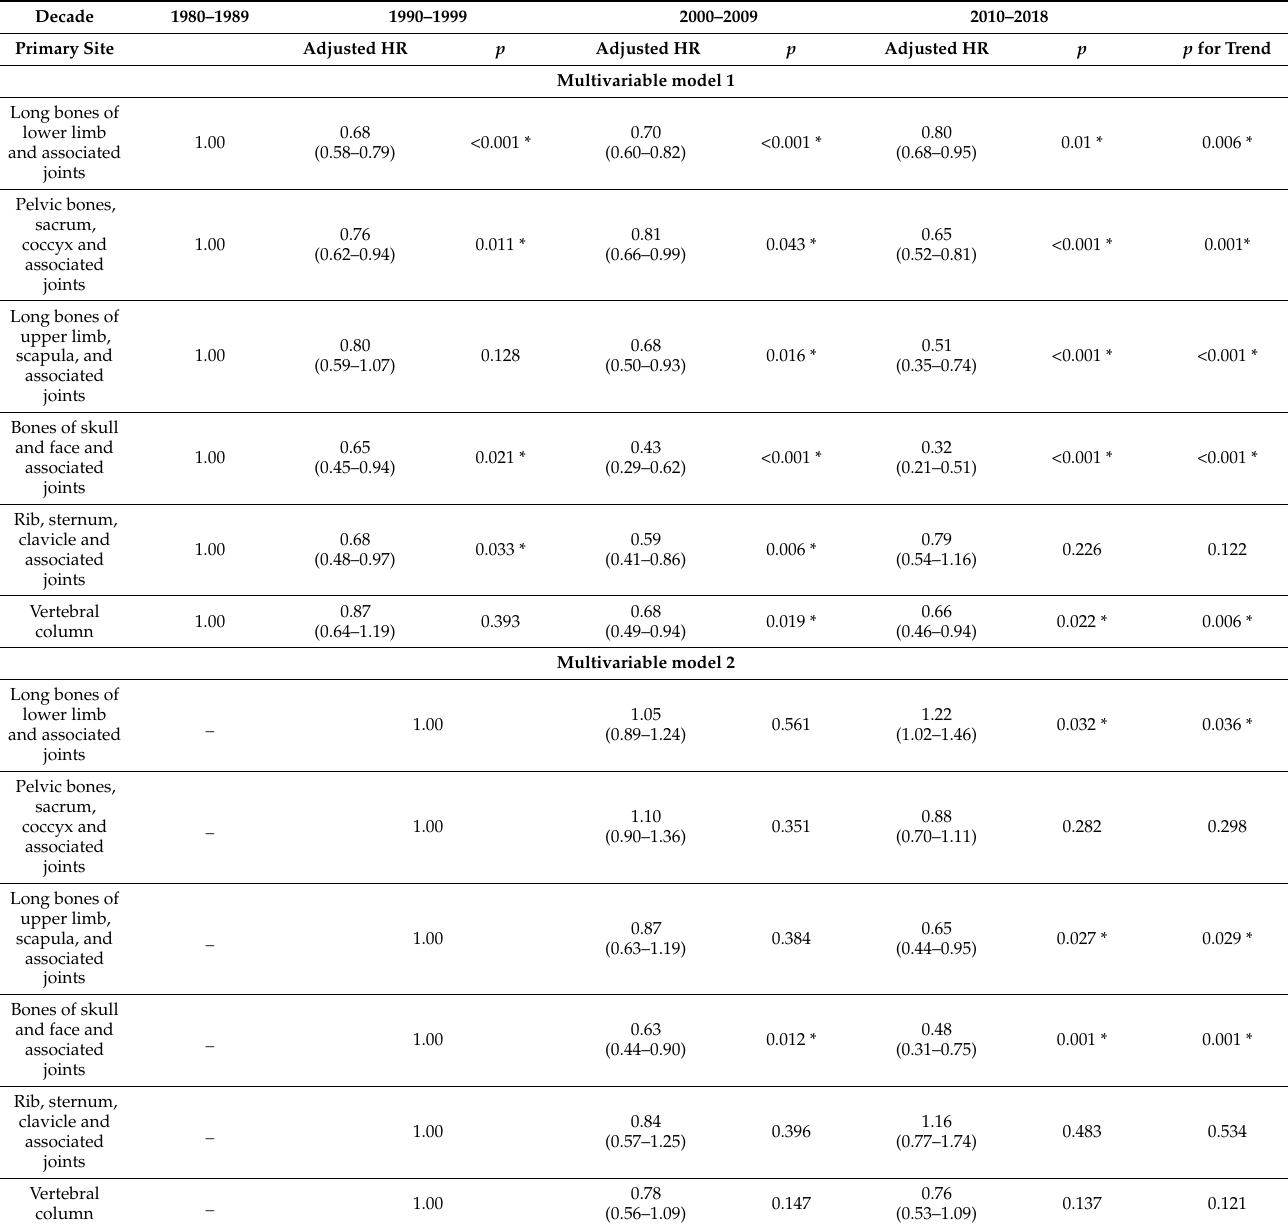
As indicated in Table 4, for six site-specific bone sarcomas, except for sarcomas at long bones of the upper limb, scapula, and associated joints, and vertebral column, all of them displayed lower CSM risks since the 1990s than in the 1980s. Sarcomas at long bones of the upper limb, scapula, and associated joints, and bones of skull and face and associated joints had further lower CSM risks in the 2010s than in the 1990s. Table 4. Trends in the adjusted HR for bone sarcomas-specific mortality (CSM) in specific tumor